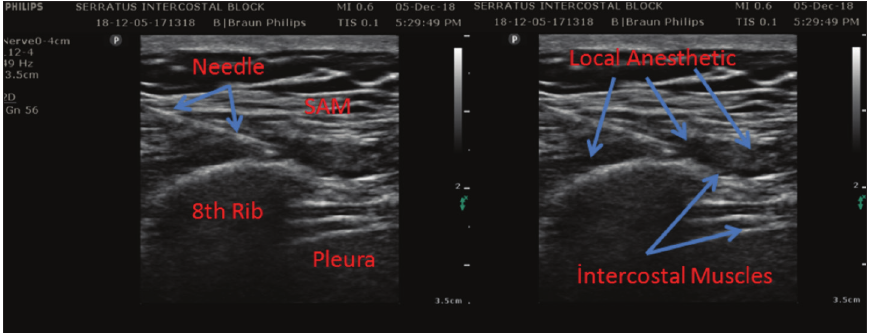
Figure 1. Demonstration of a serratus intercostal plane block. SAM: serratus anterior